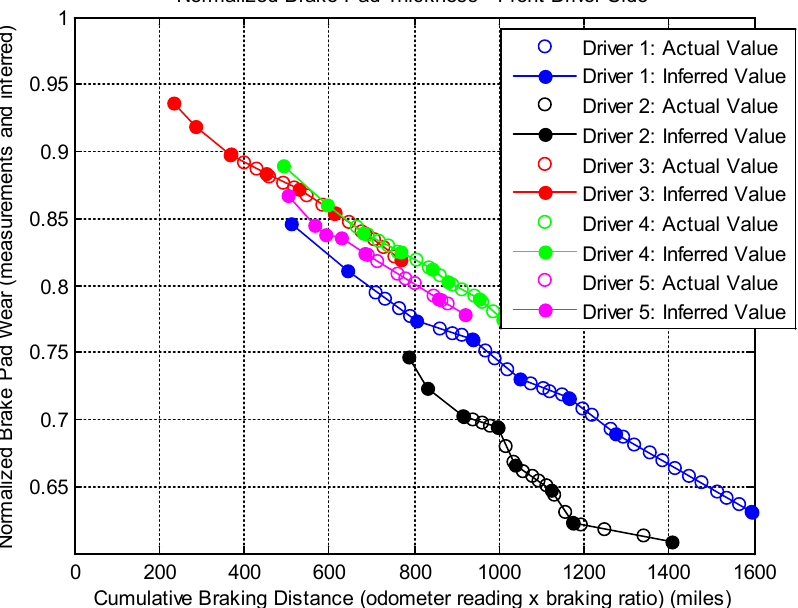
Figure 17. Measured (solid dots) and inferred (unfilled circles) RUL of front driver’s side brake pad thickness against cumulative braking distance as the X -axis.